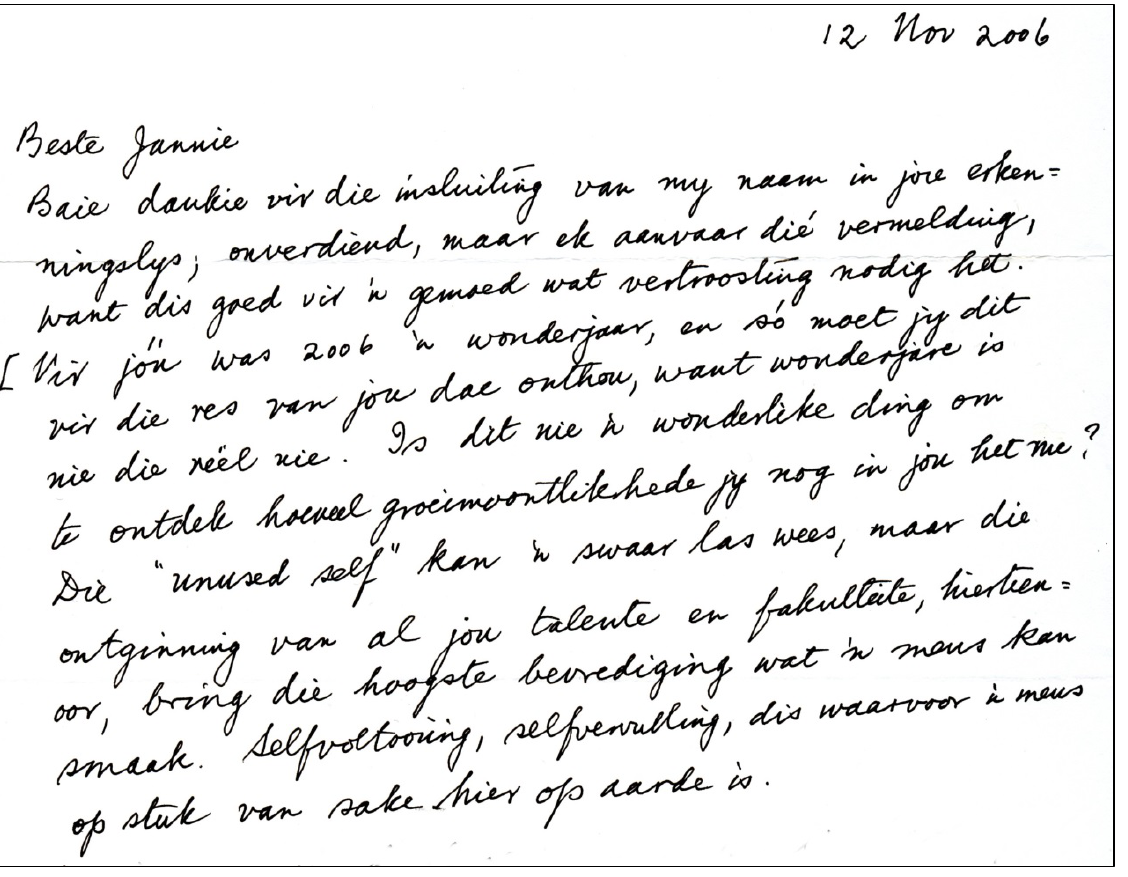
Figuur 6: Die handgeskrewe brief van 12 November